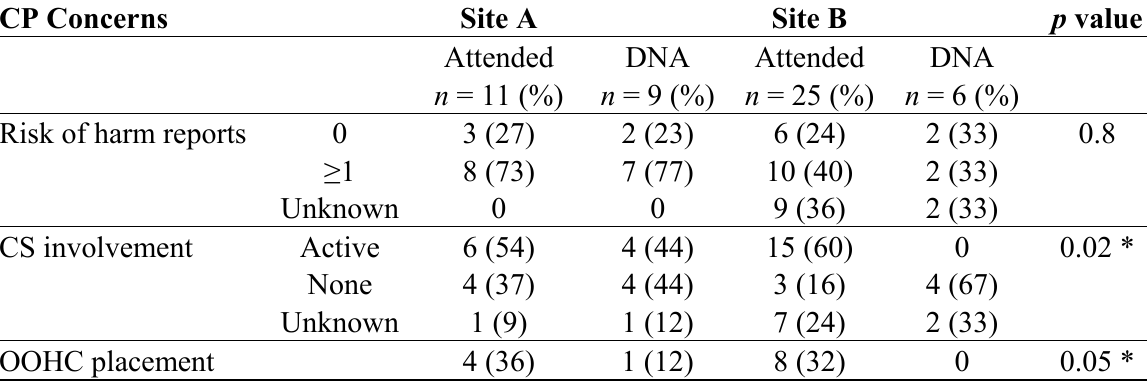
Table 2. Child protection concerns for clinic attendees versus non-attendees.